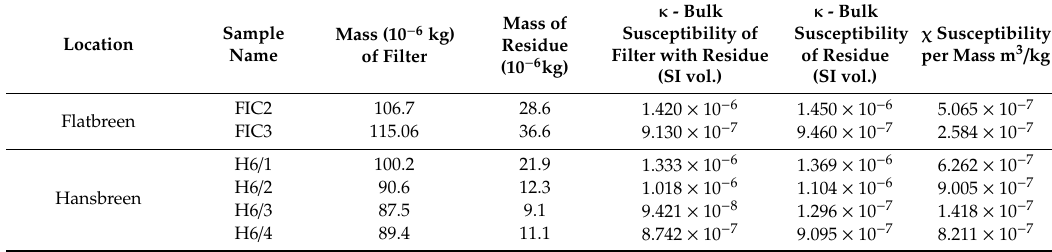
Table A2. Magnetic susceptibility data and bulk magnetic susceptibility ( κ ) of the filter with dust and for dust residue are listed; mass specific susceptibility ( χ ) for dust residue is